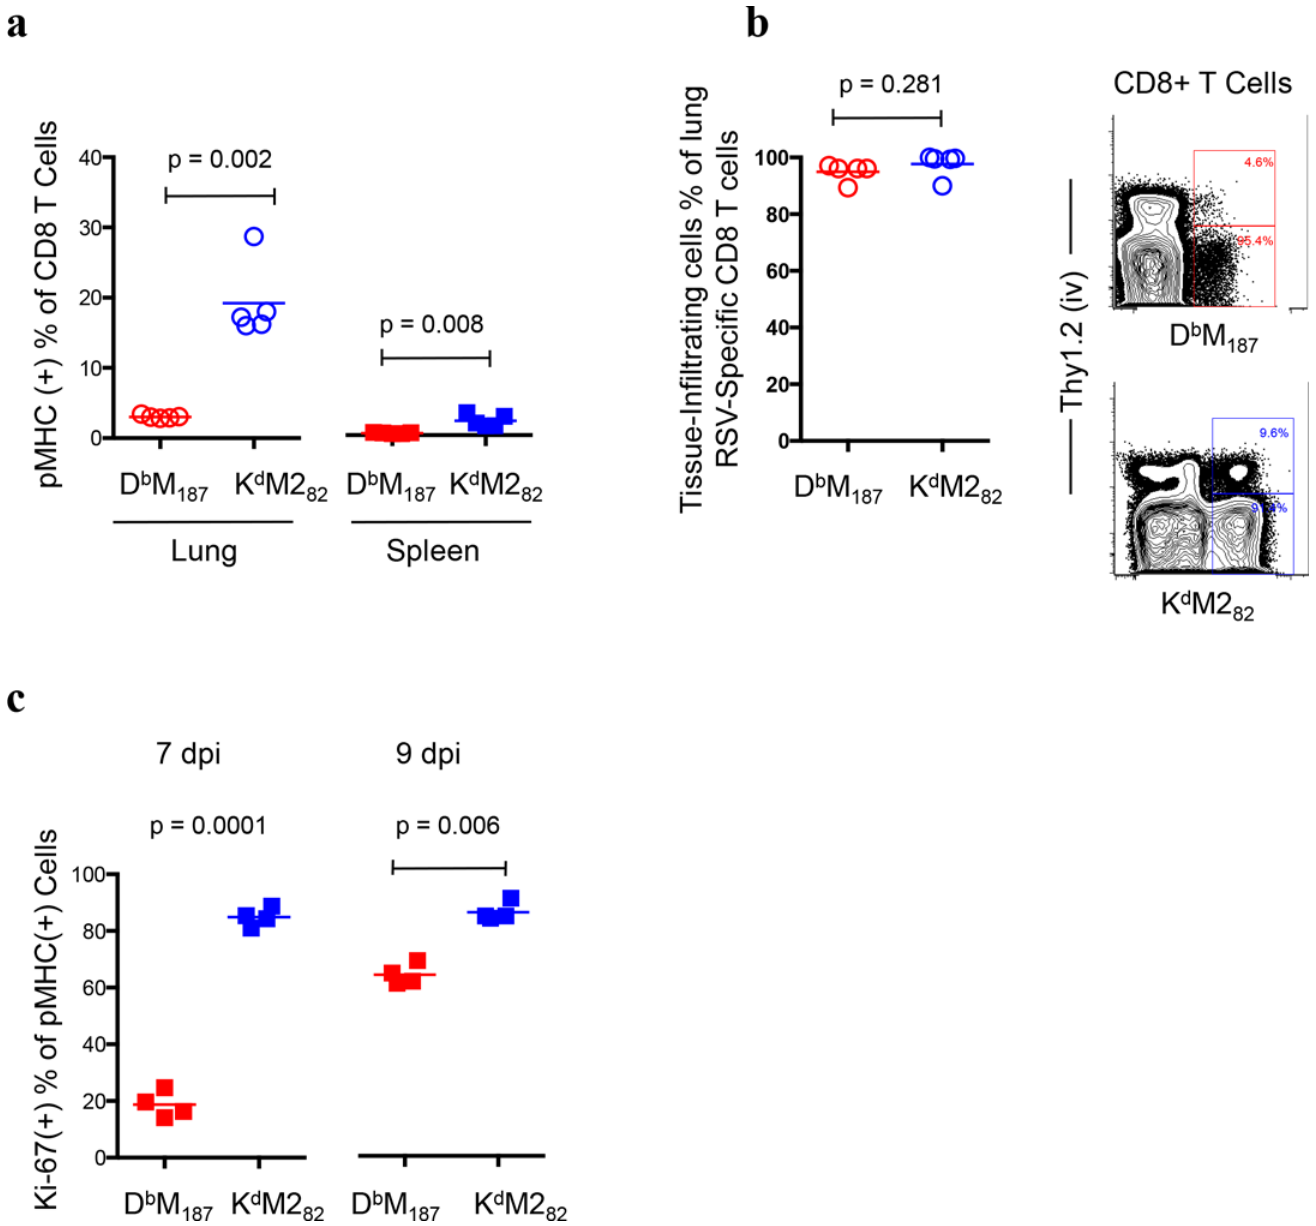
Fig 1. Numerical dominance of K d M2 82 T cell response is associated with expansion capacity. ( a ) Magnitude of D b M 187 and K d M2 82 T cell response at 7 dpi. Frequency of D b M 187 and K d M2 82 T cells in CD8 T cell population were quantitatively assessed with flow cytometry. Data represent 5 independent experiments (n = 5/group/experiment). (b ) The D b M 187 and K d M2 82 T cells infiltrate into lung parenchyma following RSV infection. Lung lymphocytes were isolated from RSV- infected mice at 7 dpi. T cells in vasculature were pre-labeled by intravenous anti-Thy1.2 staining prior to euthanizing mice. Proportion of D b M 187 and K d M2 82 T cells in lung parenchyma were quantitatively assessed with flow cytometry. Data represent 3 independent experiments (n = 5/group/ experiment). ( c ) Lymphocytes isolated from spleens at 7 and 9 dpi were studied for Ki-67 expression by flow cytometry. The frequencies of Ki-67(+) cells in D b M 187 and K d M2 82 T cell subsets are shown. Data represent 3 independent experiments (n = 4/group/experiment). All data are shown as mean with independent data point and compared by Student t-test. Each symbol represents one mouse. doi:10.1371/journal.ppat.1005486.g001 of targets lysed by individual CD8 T effector cells. We found that individual D b M T cells 187 lysed more targets than K d M2 T cells ( Fig 2B ), and both subsets more efficiently lysed targets 82 and K d M2 T cells). in spleen than they did in lung (p < 0.0001 for both D b M 187 82